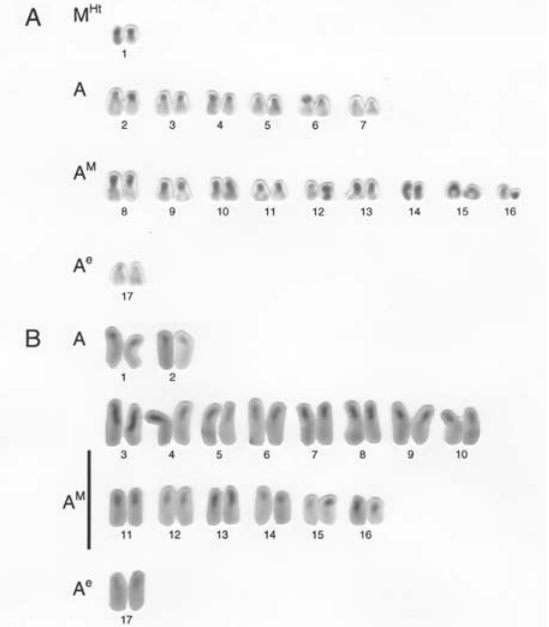
Figure 1 - Karyotypes assembled from metaphases of female Trigona chanchamayoensis (A) and Trigona branneri (B) following C-banding. The nomenclature is based on that proposed by Imai (1991).